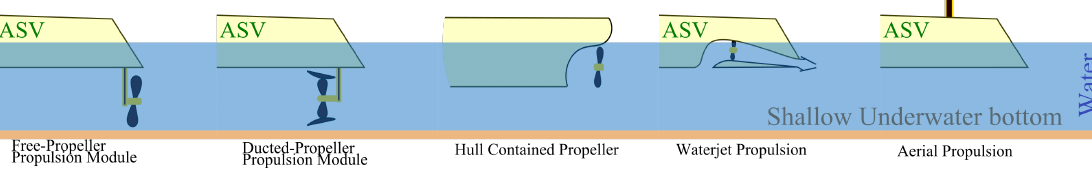
Figure 2. Existing ASV propulsion